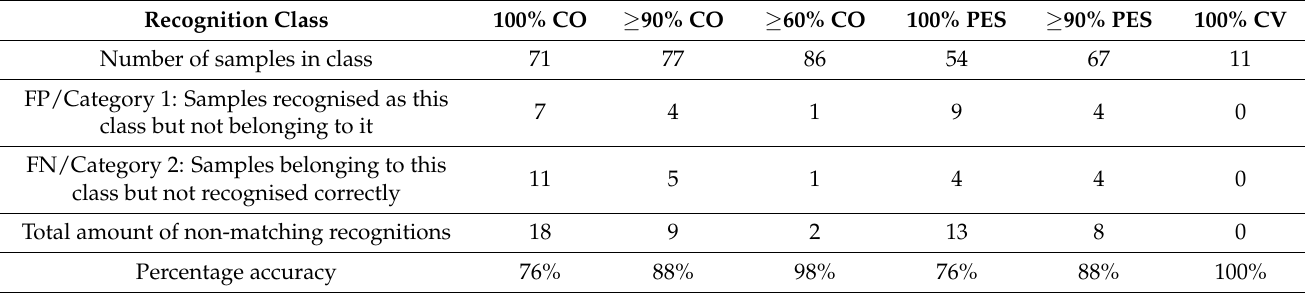
Table 1. Recognition classes, the number of samples with non-matching results grouped into two categories, and percentage accuracy.